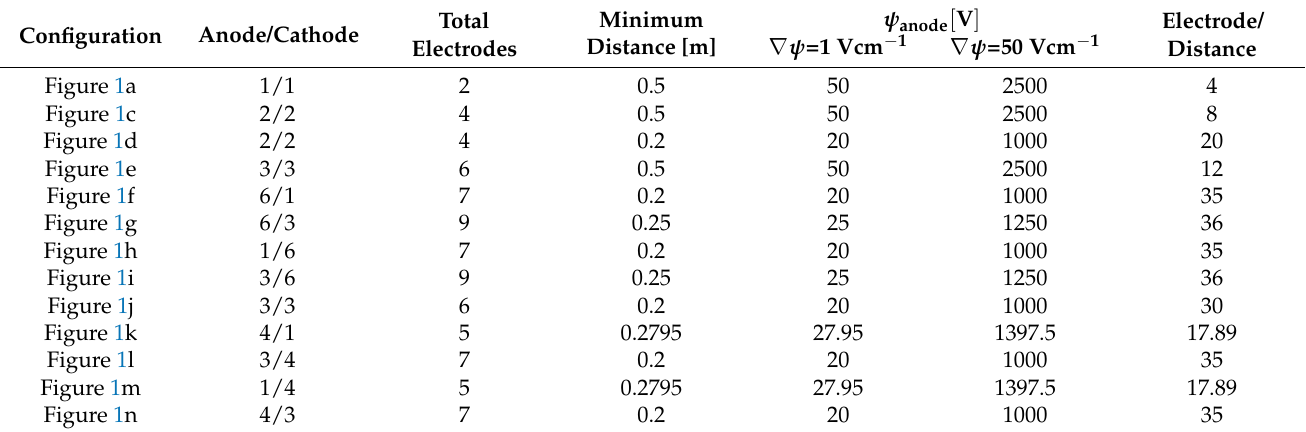
Table 3. Characteristics of the simulations for electrode configuration